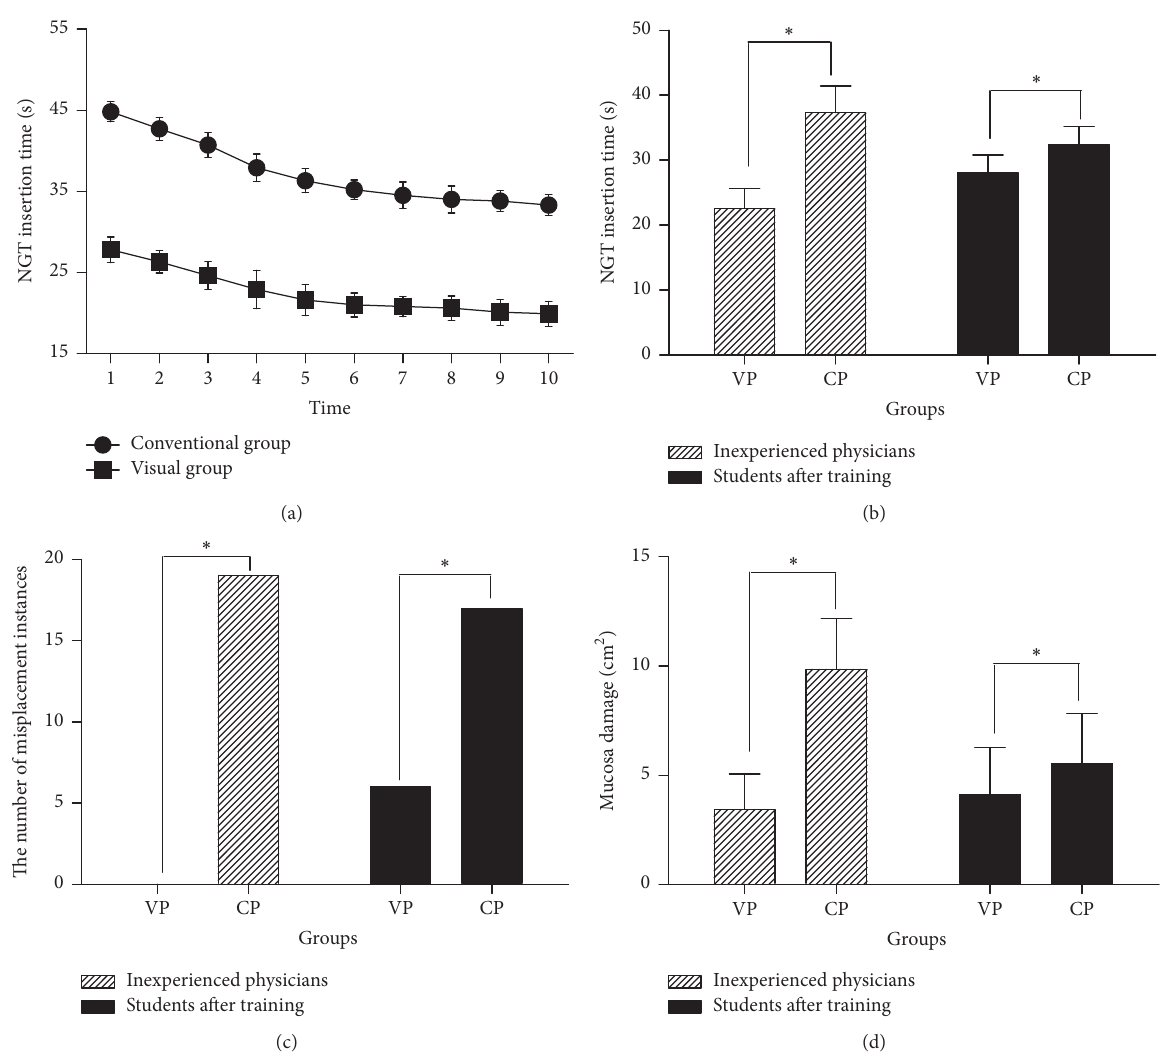
Figure 2: (a) Graph showing the nasogastric tube insertion times of the visual group (VP) and conventional group (CP) of inexperienced physicians with repeated measurements. (b) Comparison of nasogastric tube insertion times. (c) Comparison of nasogastric tube misplacement. (d) Comparison of damaged mucosal areas ( ∗ indicates 𝑃 < 0.05